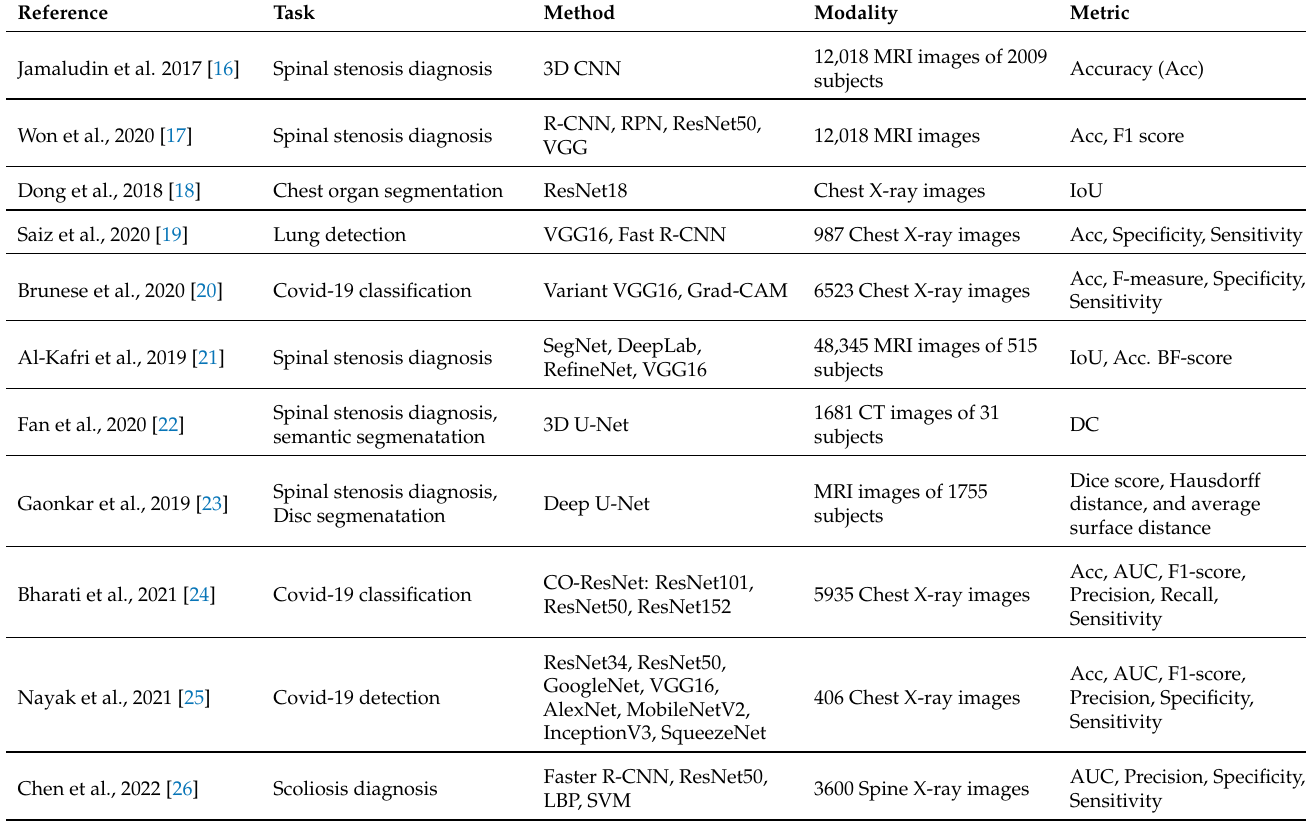
Table 1. Overview of studies using deep learning for medical images, especially X-ray images or spine